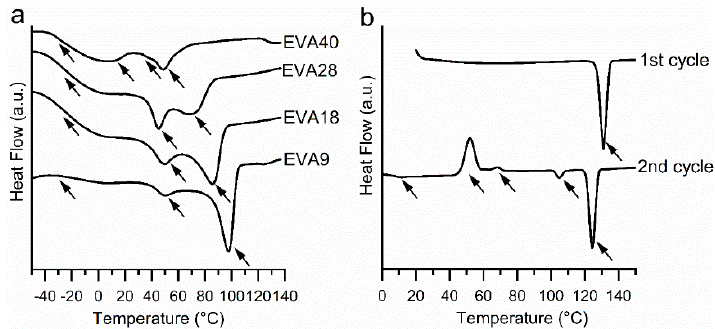
Figure 1. Differential scanning calorimetry (DSC) thermograms (total heat flow, exo up) of ( a ) Ethylene-vinyl acetate (EVA) polymers recorded during the first heating cycle and ( b ) Progesterone (P4) recorded during the first and second heating cycles. The arrows indicate thermal events.